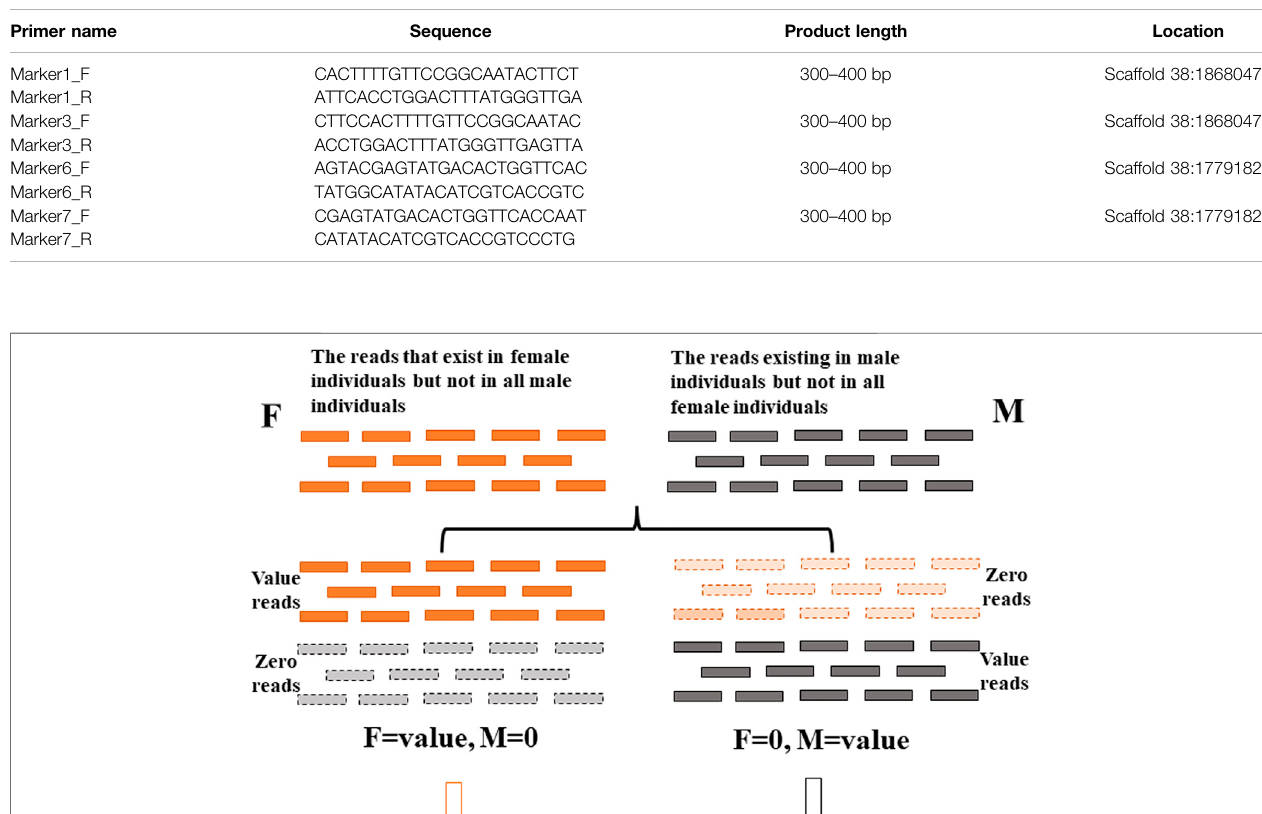
Frontiers in Genetics |